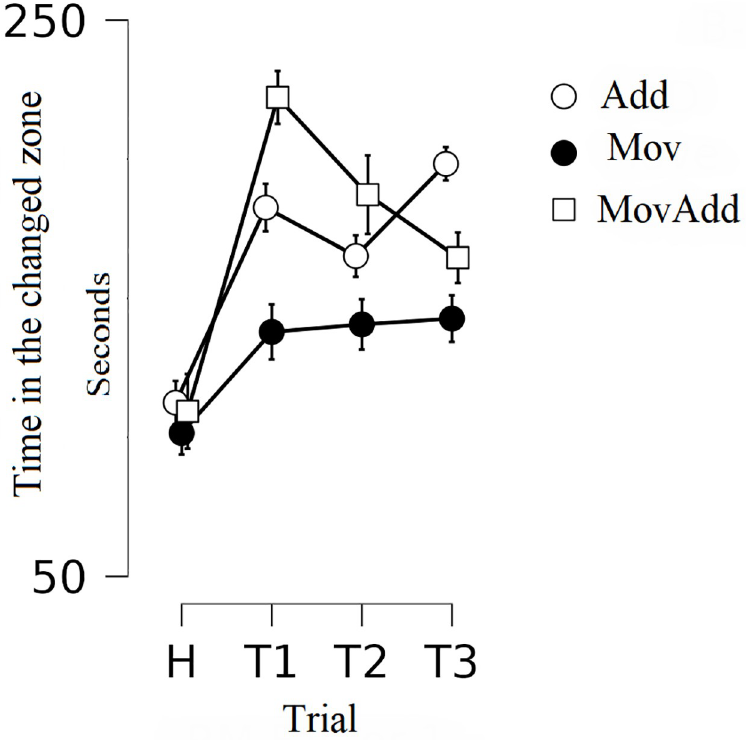
Fig 3. Mean time spent by rats in the changed zone of the chamber. Group Add: addition of novel stationary objects in the experimental box, group Mov: movement of familiar objects in the experimental box, group MovAdd: addition of a novel movable object in the experimental box. Error bars represent standard error